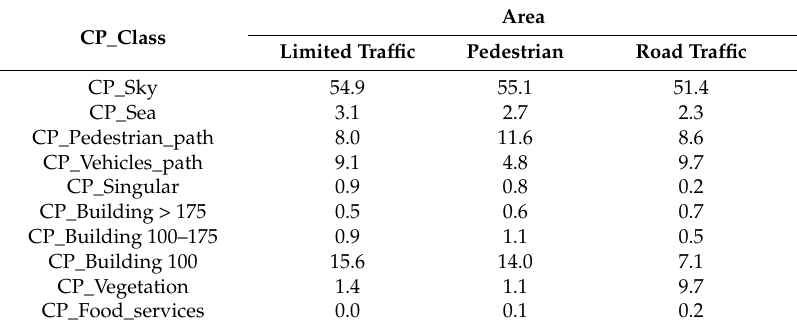
Figure 5. Boxplot of the appraisals of the soundscape quality, (rated in a 7 points Likert scale from 1 (very low) till 7 (excellent)), in the three types of areas a priori classified as pedestrian areas, open to road traffic areas and limited traffic areas (bottom horizontal axis). Table 2. Mean values of the percentages in the panoramic photographs (CP) of all the classes in the three types of